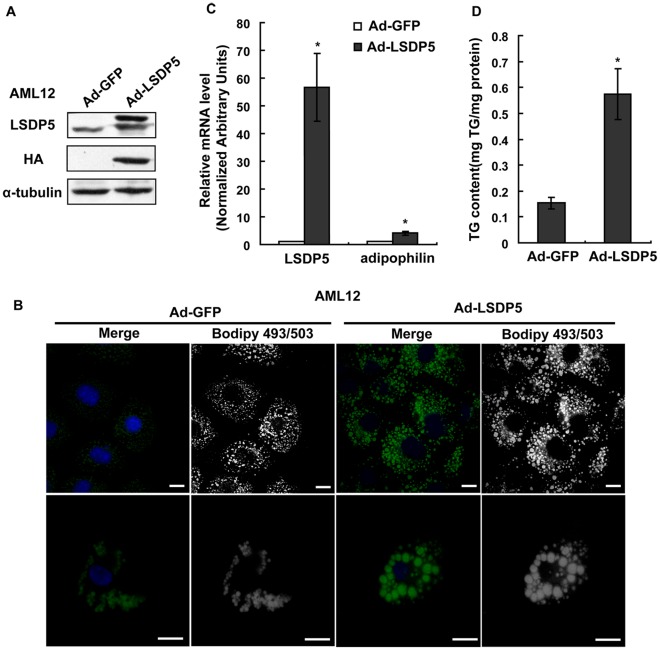
The overexpression of LSDP5 increased cellular TG storage in AML12 cells.(A) Adenovirus-mediated HA-LSDP5 overexpression in AML12 cells was confirmed by Western blotting. Expression levels of LSDP5 are expressed as a ratio to α-tubulin (representative of three experiments). (B) AML12 cells were infected with adenovirus encoding LSDP5 for 6 h and then incubated with 200 µM oleate for 24 h. Neutral lipids were stained with BODIPY 493/503, and nuclei were labeled with Hoechst 33258. The immunofluorescent signals of both BODIPY 493/503 (green) and Hoechst 33258 (blue) are shown in the merged panels. The BODIPY immunofluorescent signals are shown in the BODIPY493/503 panels and were edited to grayscale to provide clearer lipid signals and reduce interference from the immunofluorescent signal of the nucleus. Scale bar = 15 µm. (C) The relative mRNA levels of LSDP5 and adipophilin were assessed using real-time PCR. Data are presented as the mean±SEM (n = 4), *
P<0.05. (D) A higher concentration of TGs was observed in cells overexpressing LSDP5 compared with controls. Data are presented as the mean±SEM (n = 5), *
P<0.05. Data in this figure were analyzed with paired Student’s t test.